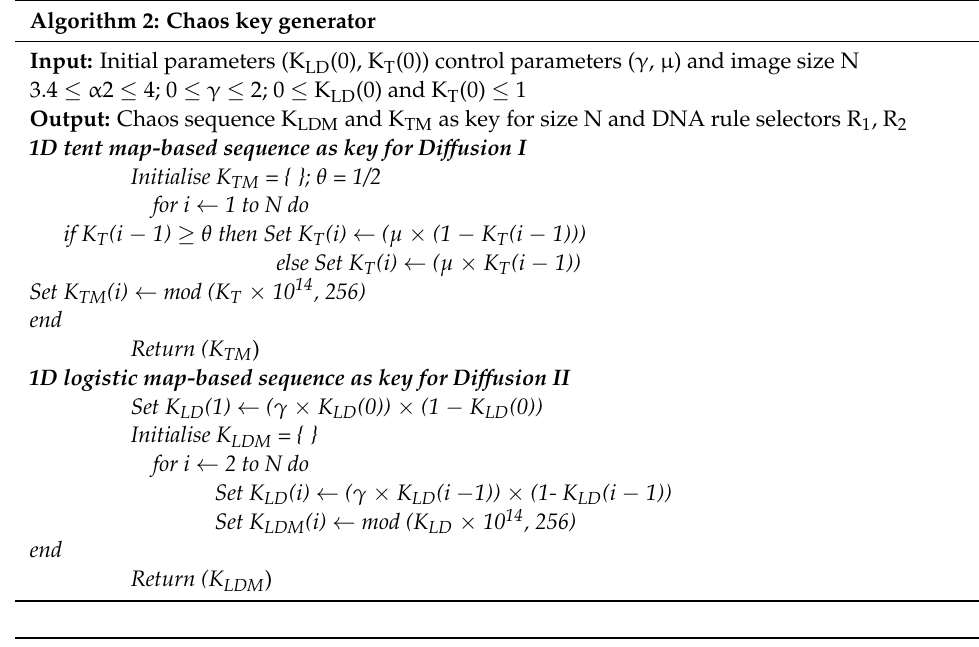
Algorithm 2: Chaos key generator